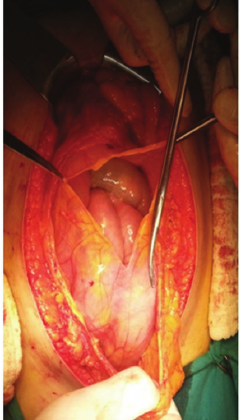
Figure 2: Small intestines located in lesser sac and the surrounding